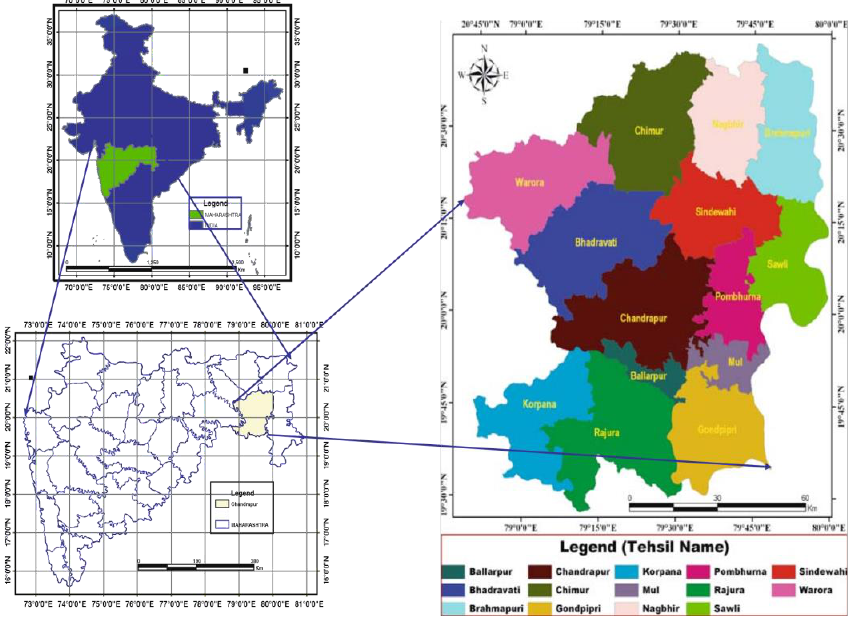
Figure 1. Chandrapur district with administrative blocks